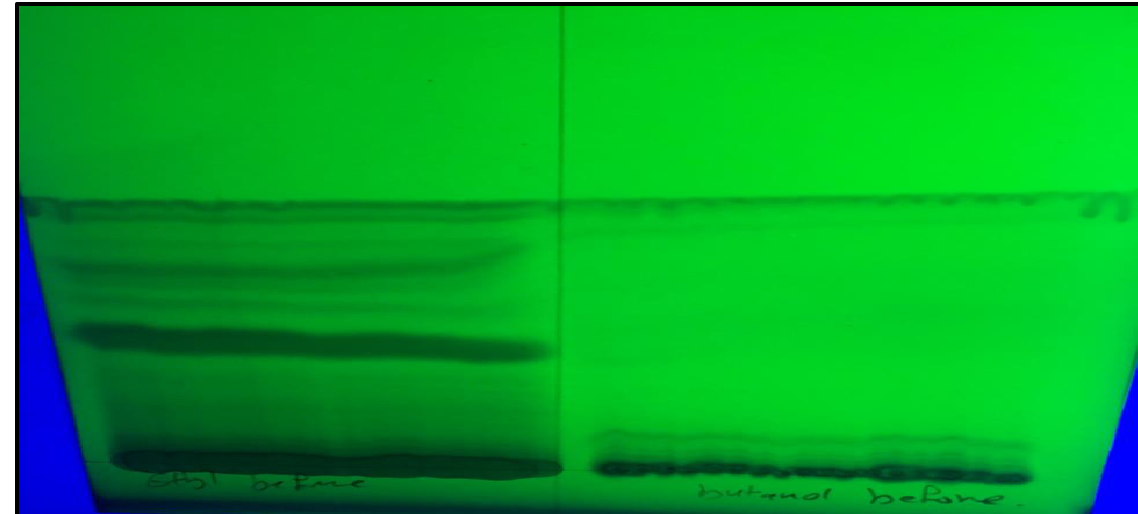
Figure 2. Preparative Thin layer chromatography on silica gel GF (1) Fraction of ethyl acetate before hydrolysis (2) fraction of n-butanol before hydrolysis. Using solvent system P1 (CHCl 3 :CH 3 OCH 3 : HCOOH) in a ratio (75:16.5:8.5). The detection under UV light 365 and 254 nm, P1 which is best mixture of solvents used in the separation of phenolic compound from fractions.